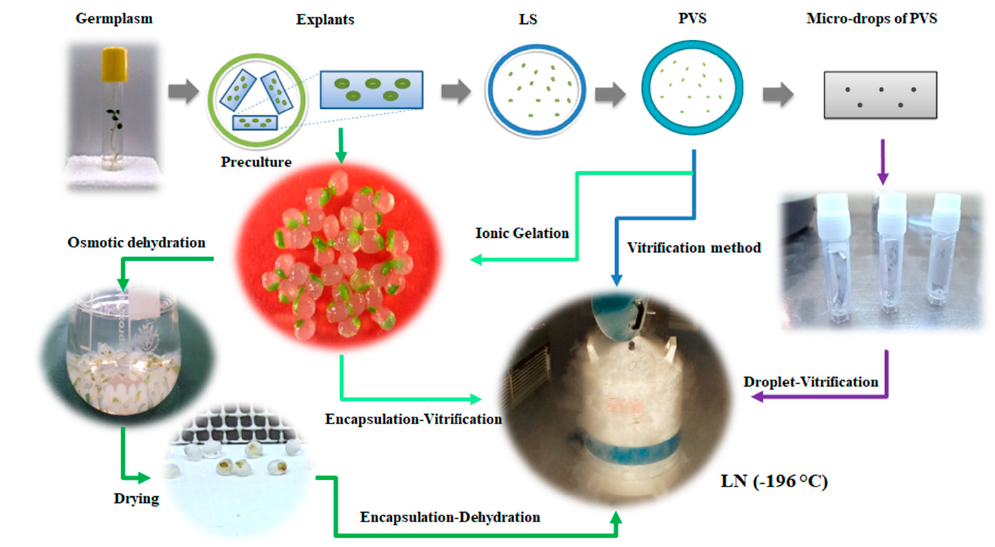
Figure 2. Most common modern cryopreservation